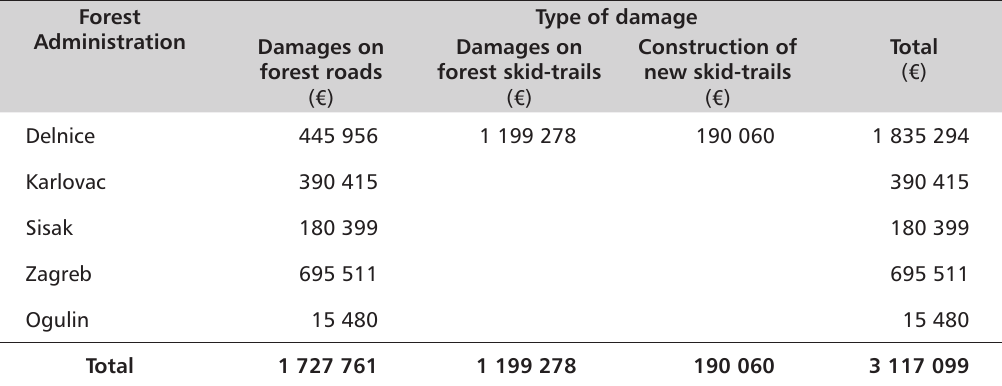
TABLE 3. Summarized costs of damages on forest roads and forest